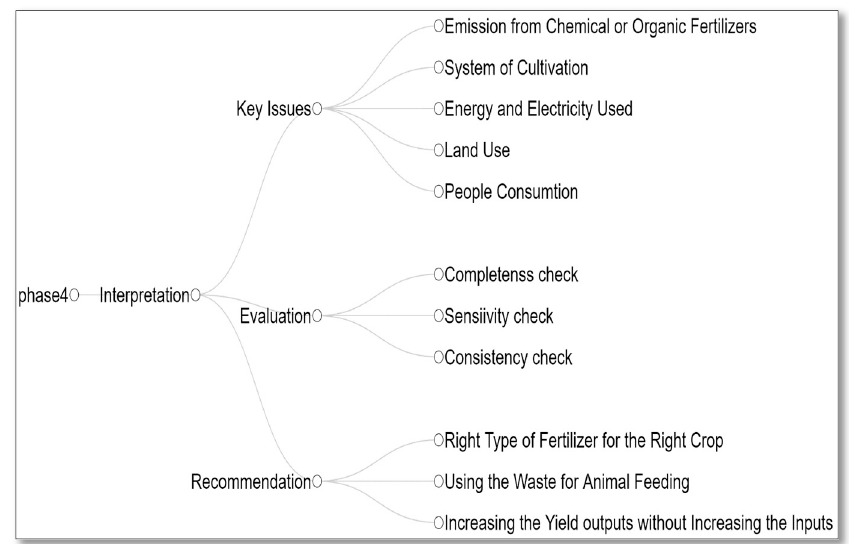
Figure 17. Phase 4 (interpretation/recommendation) of life cycle assessment (LCA).